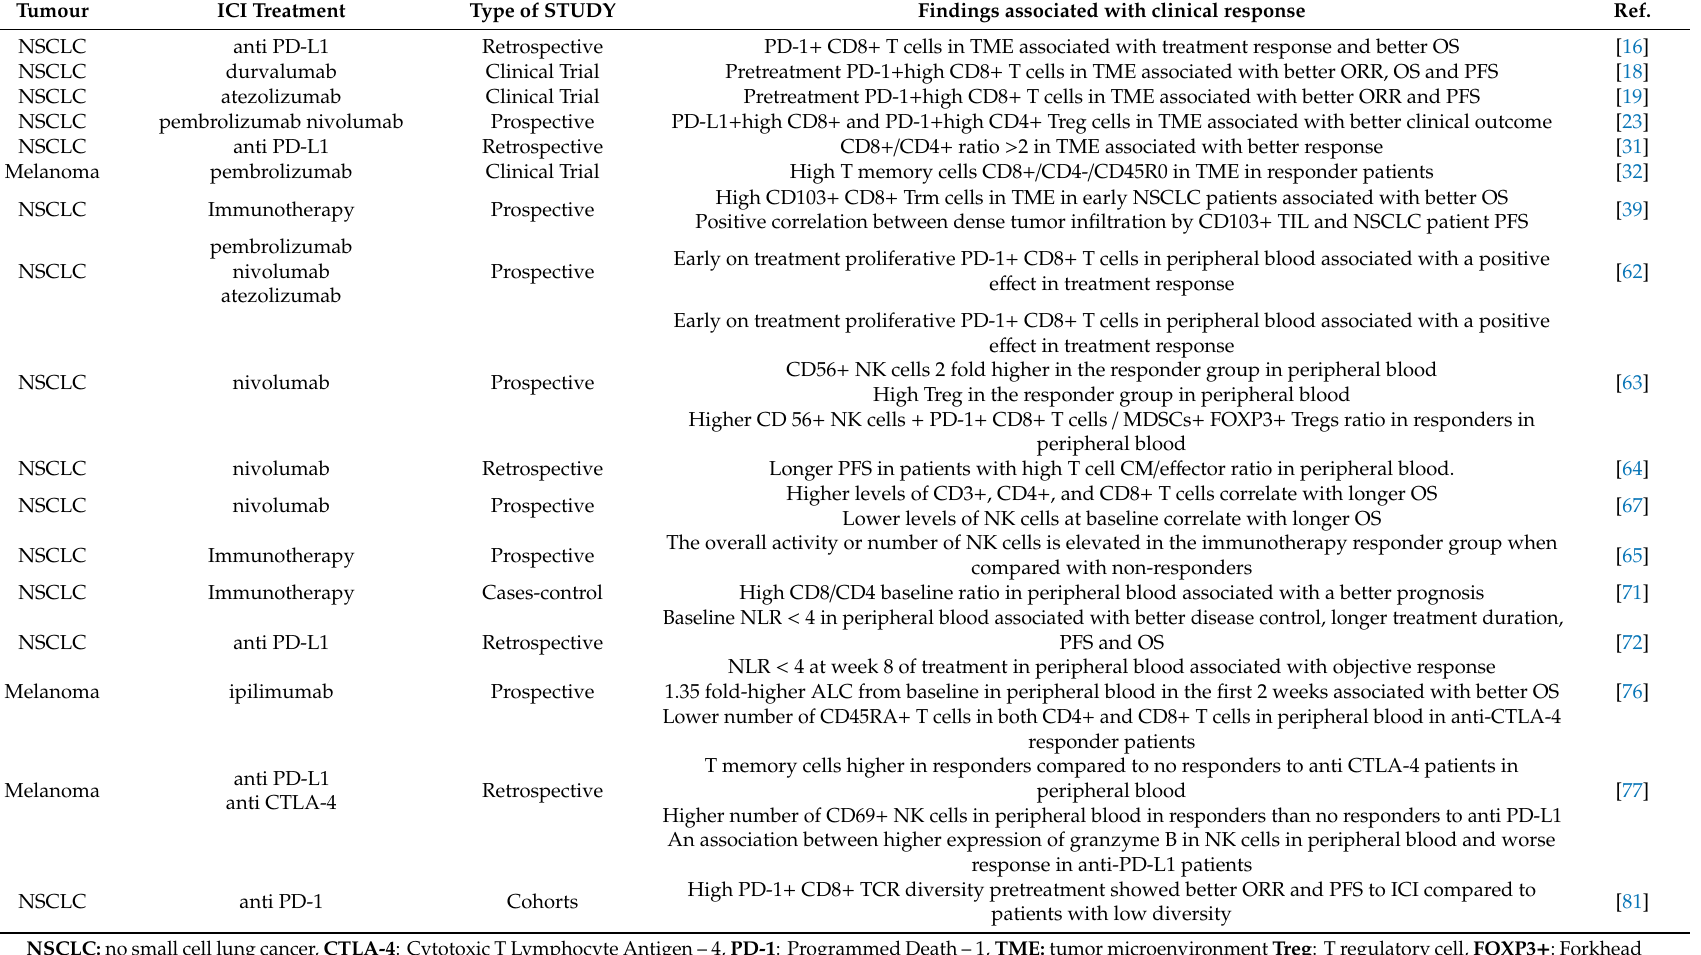
Table 1. Studies from biomarkers of